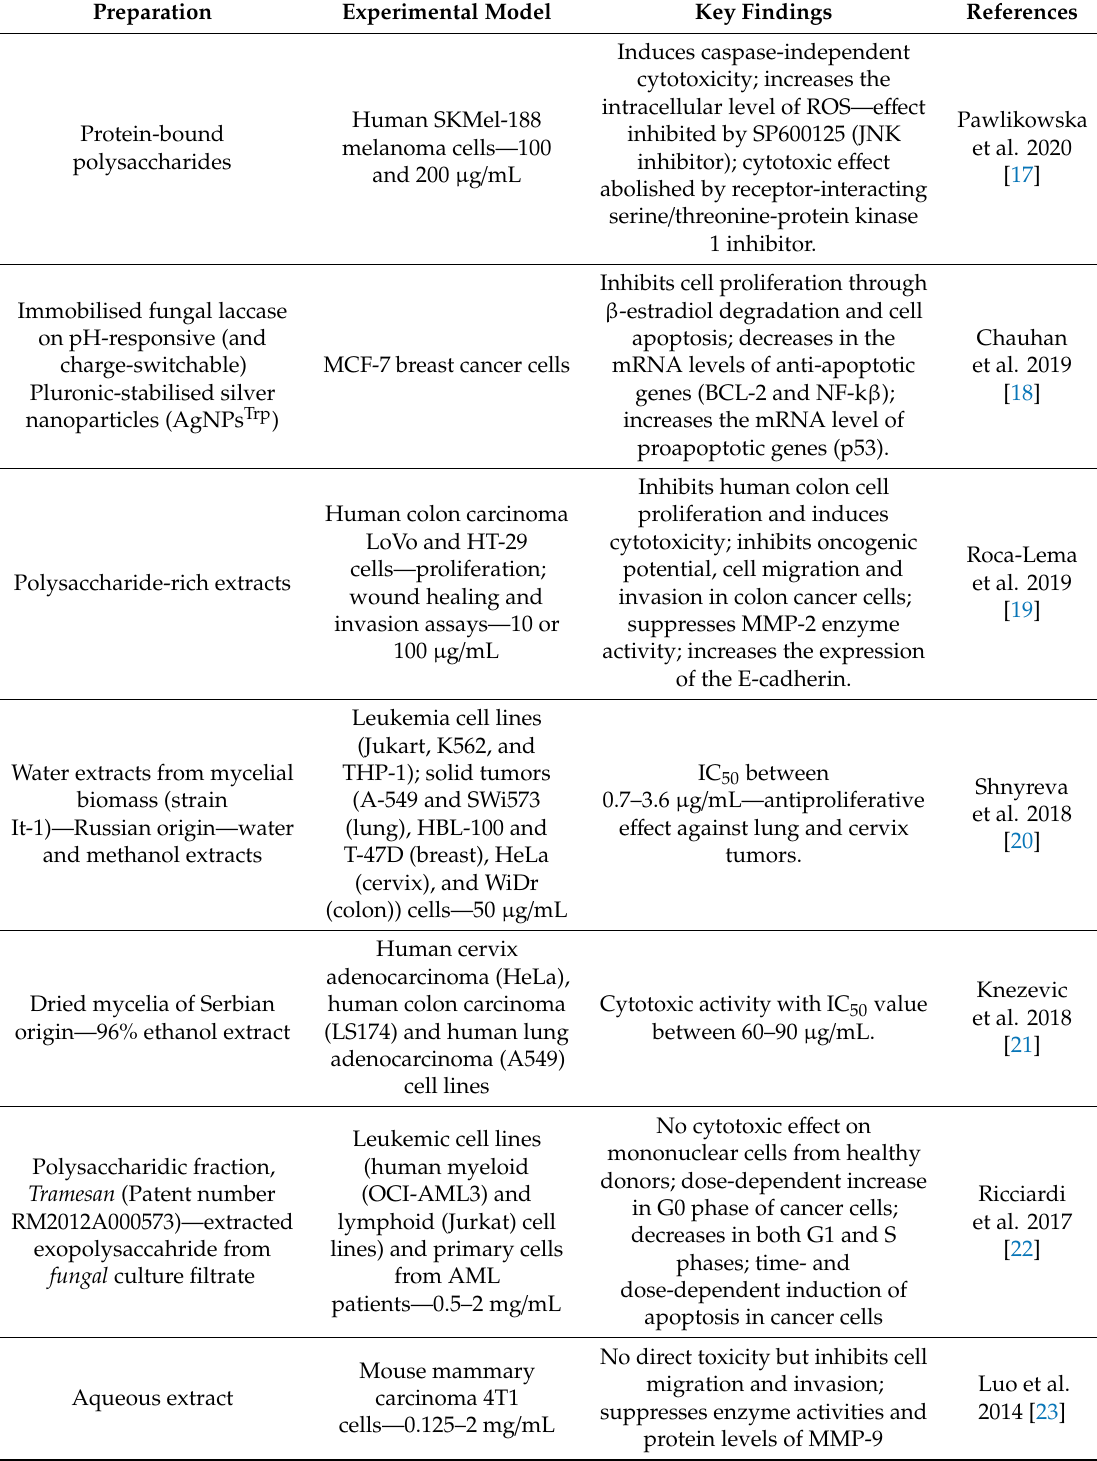
Table 1. Direct cytotoxic e ff ects in